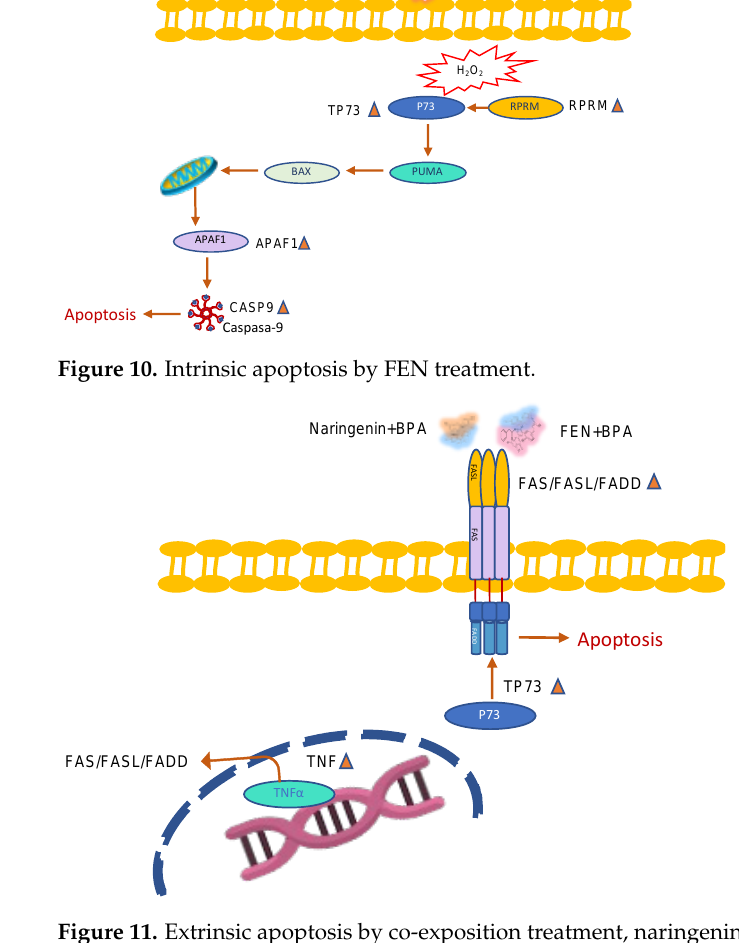
Figure 11. Extrinsic apoptosis by co-exposition treatment, naringenin +BPA and FEN+BPA. The decrease in cell viability as well as the recovery of ER β gene expression on HT-29 cells under treatment with naringenin and its extract FEN suggest that the expression of this receptor is associated with apoptotic mechanisms and DNA damage repair,